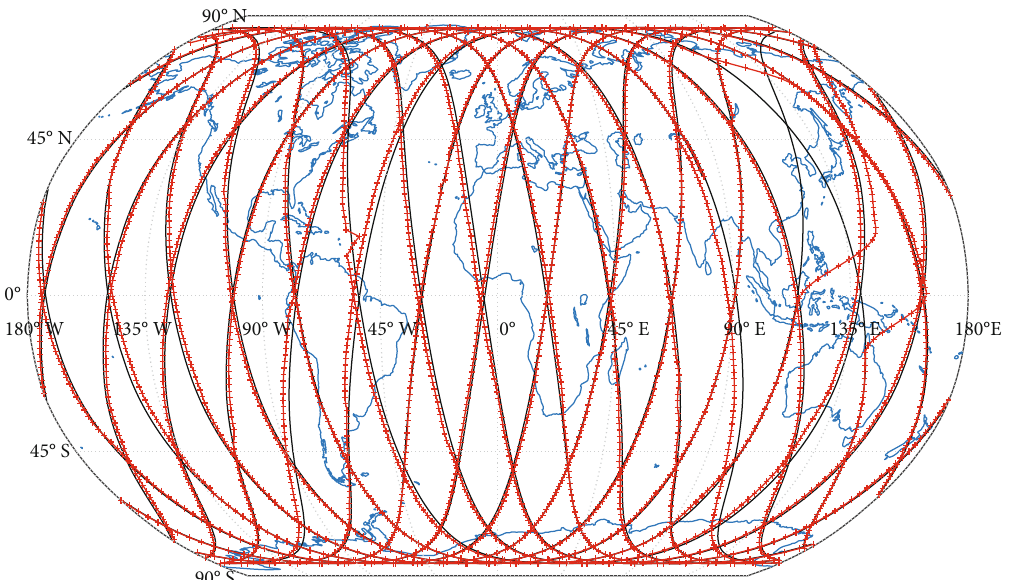
Figure 7: Ground track of KOMPSAT-5 (black) and the cross-track error of (RD-KIN) (red) for 14 July